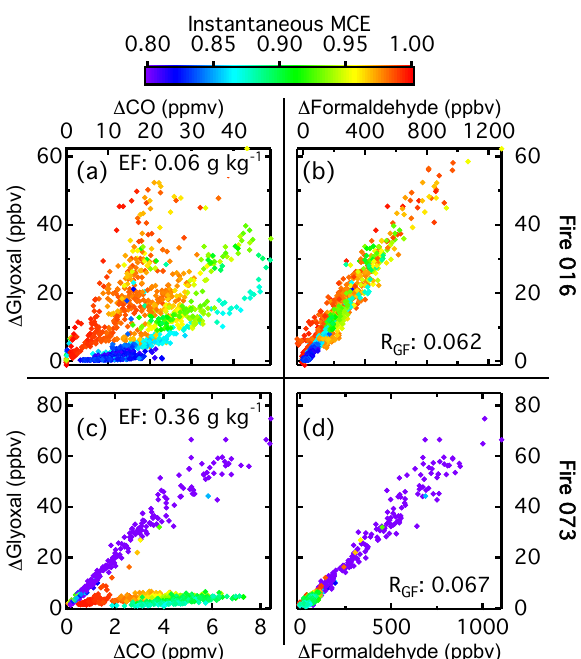
Figure 5. (a) Glyoxal as a function of CO for Fire 016 (ponderosa pine litter). (b) Glyoxal as a function of formaldehyde for the same burn. Glyoxal as a function of CO (c) and formaldehyde (d) for Fire 073 (ponderosa pine rotten log). The markers in all plots are colored by the instantaneous MCE.